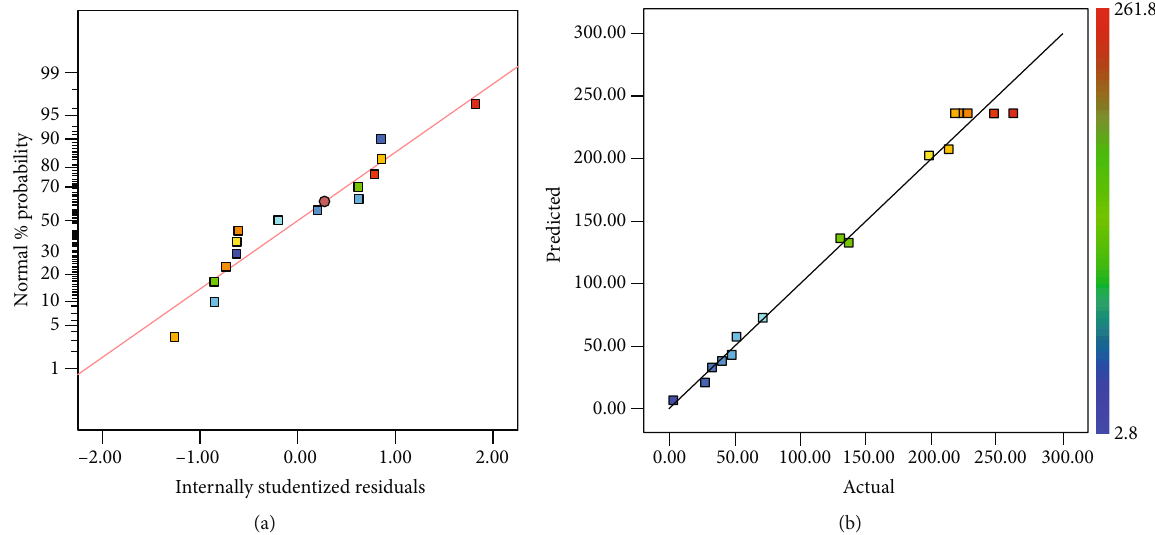
Figure 1: Plots of standardized residuals vs. normal % probability for biogas production (a). Actual and predicted values of biogas production